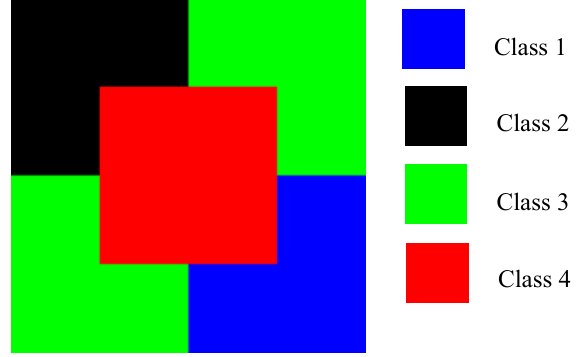
Figure 4. The ground data of Example